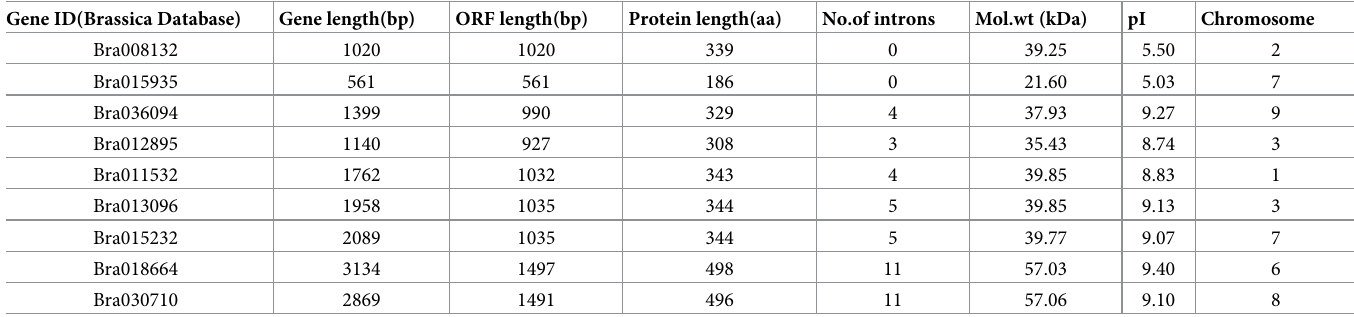
together in a tandem fashion within a 120-kb region. The seven identified clusters were distrib- uted as follows: two each on chromosomes A07 and A09 and one cluster each on chromo- somes A01, A02 and A03. No clusters were located on chromosomes A04, A06, A08 or A10.